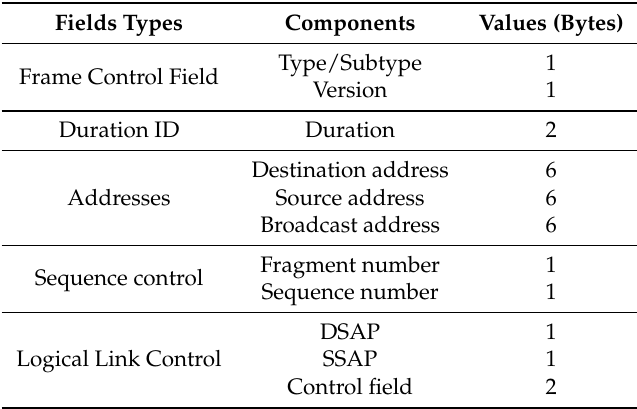
Table 4. FCF and LLC sub-frame